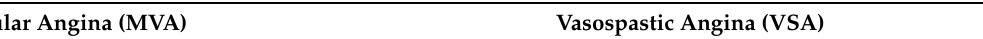
Table 2. Diagnostic criteria of microvascular angina (MVA) and vasospastic angina (VSA), according to the COVADIS